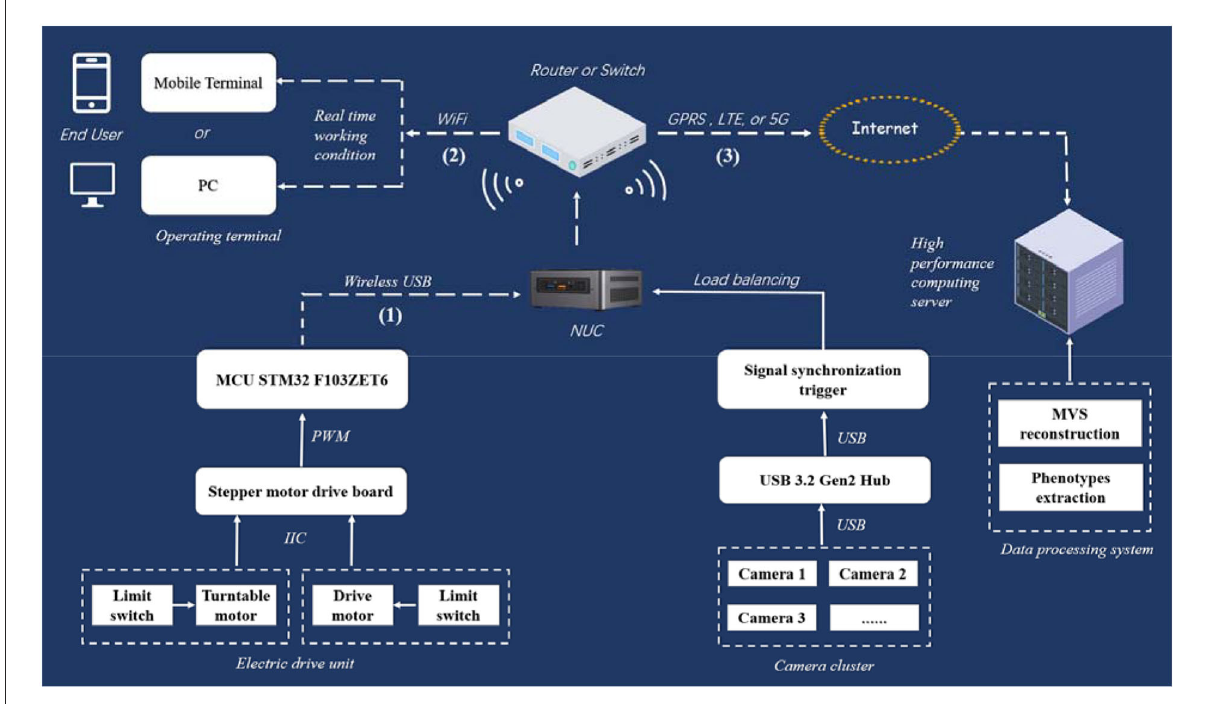
FIGURE3 Physical circuit diagram of network communication and signal control in MVS-Pheno V2